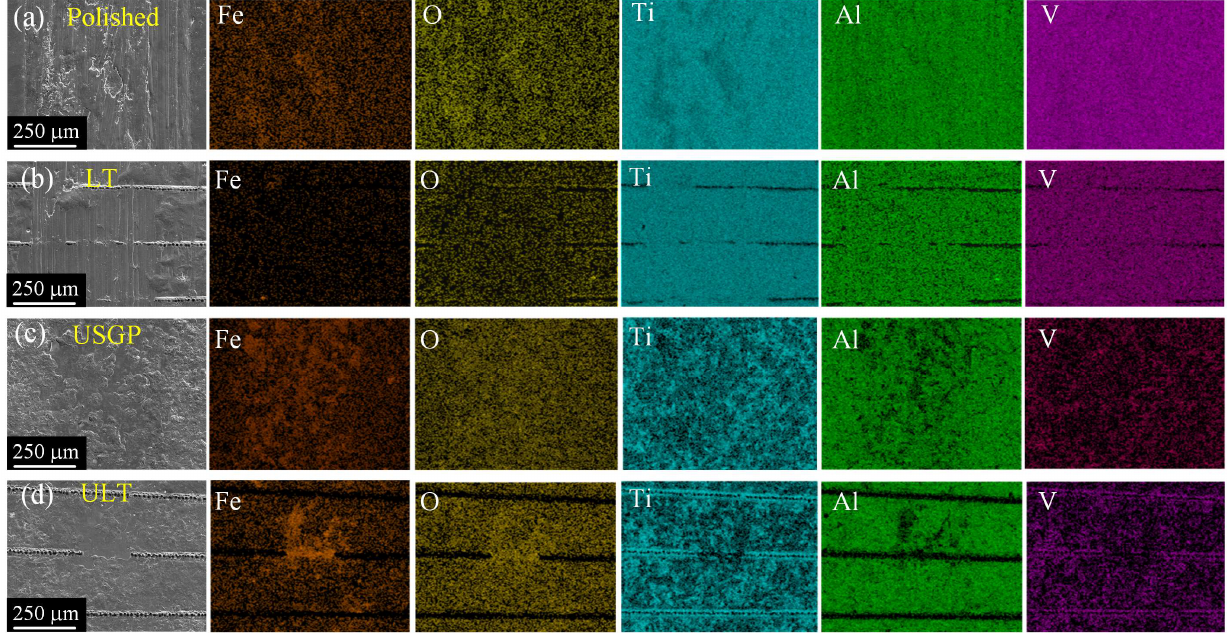
Figure 11. EDS elemental maps of the polished ( a ), LT ( b ), USGP ( c ), and ULT ( d ) samples after sliding under a fixed normal load of 15 N for 3600 s at a constant sliding velocity of 30 mm/s.